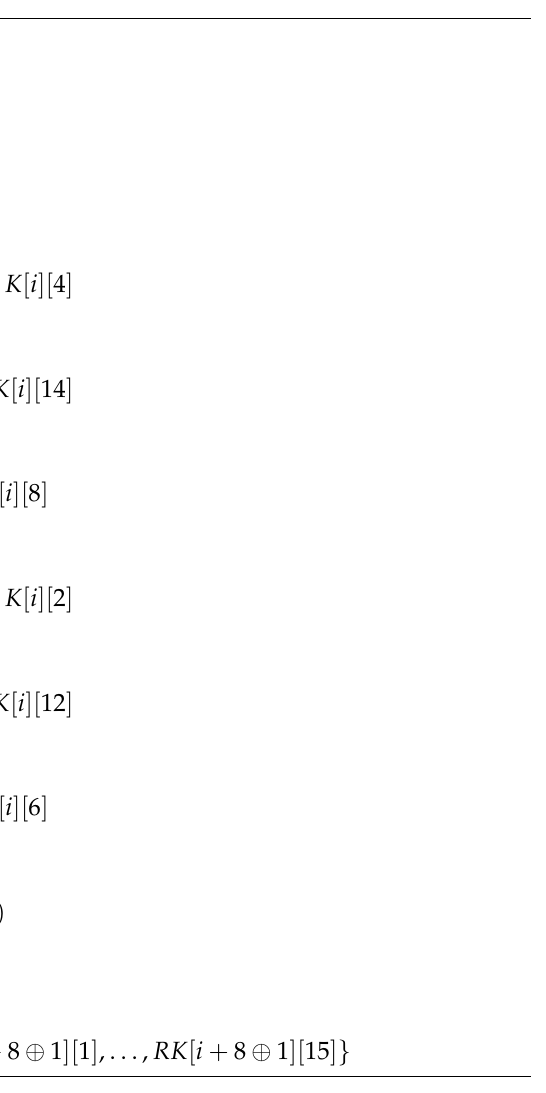
Algorithm 8 RK [ i + 8 ⊕ 1 ] key schedule of